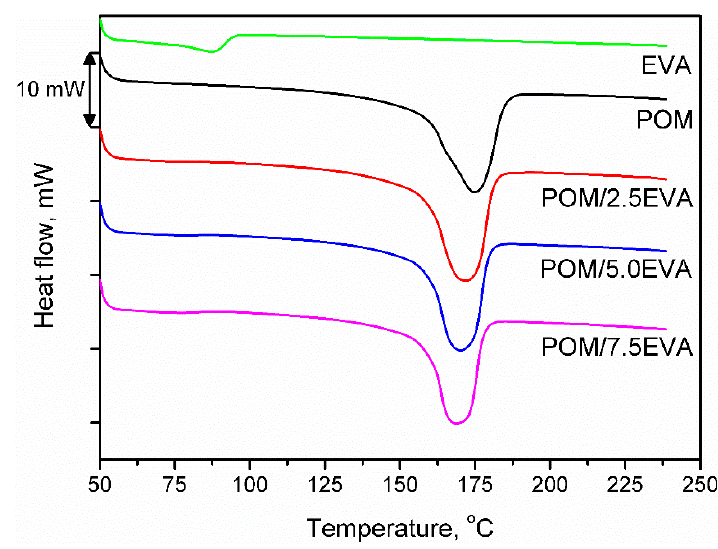
Figure 4. DSC thermograms for prepared samples.